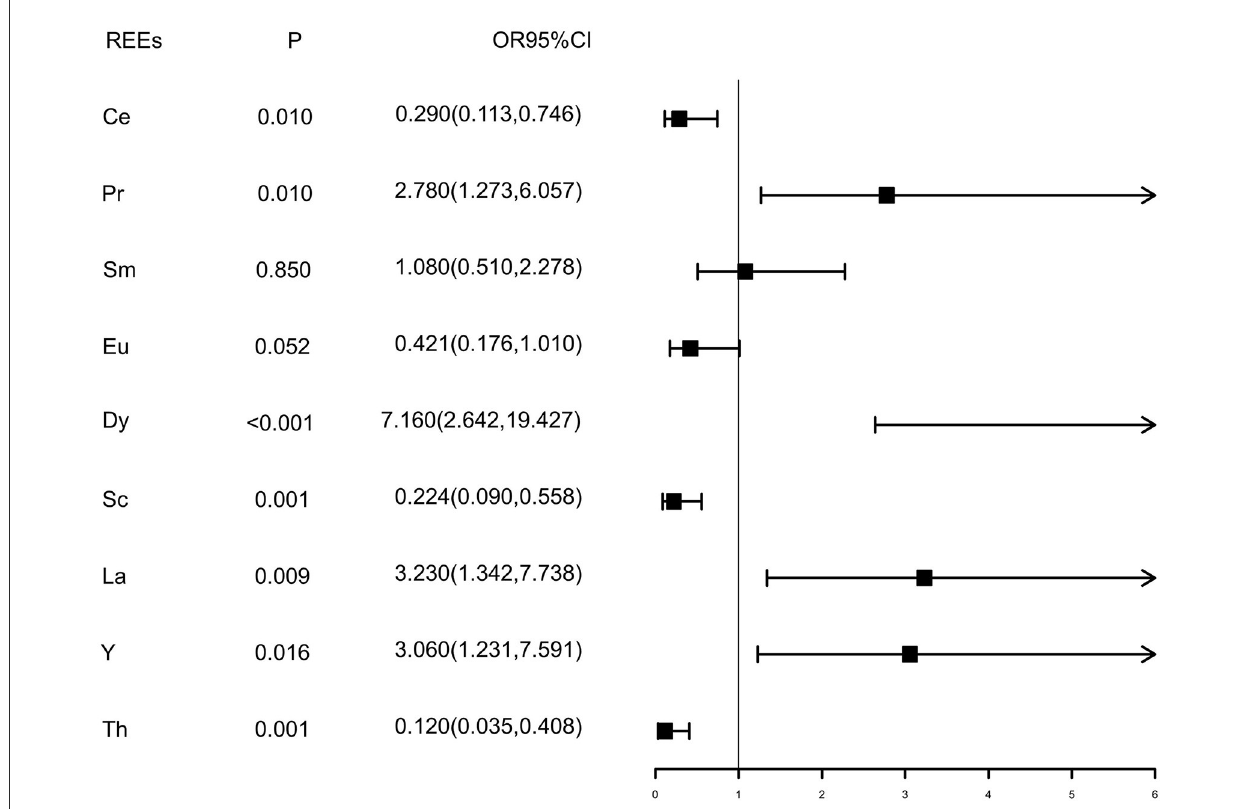
FIGURE2 Multivariate conditional logistic regression results of REE elements. Pd: P-values of conditional logistic regression adjusted age, gender, residence, family history of cancer, BMI and alcohol drinking, tobacco smoking, tea drinking, and fruits, seafood, fish, green leafy vegetables, non-green leafy vegetables, milk, egg, meat, processed meat, and pickled food